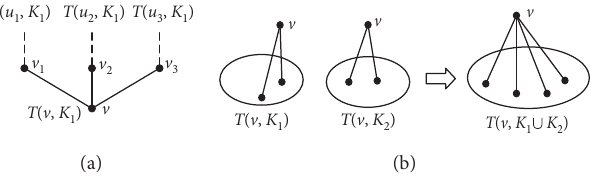
Figure 6: Tree operations. (a) Tree growth operation. (b) Tree merging